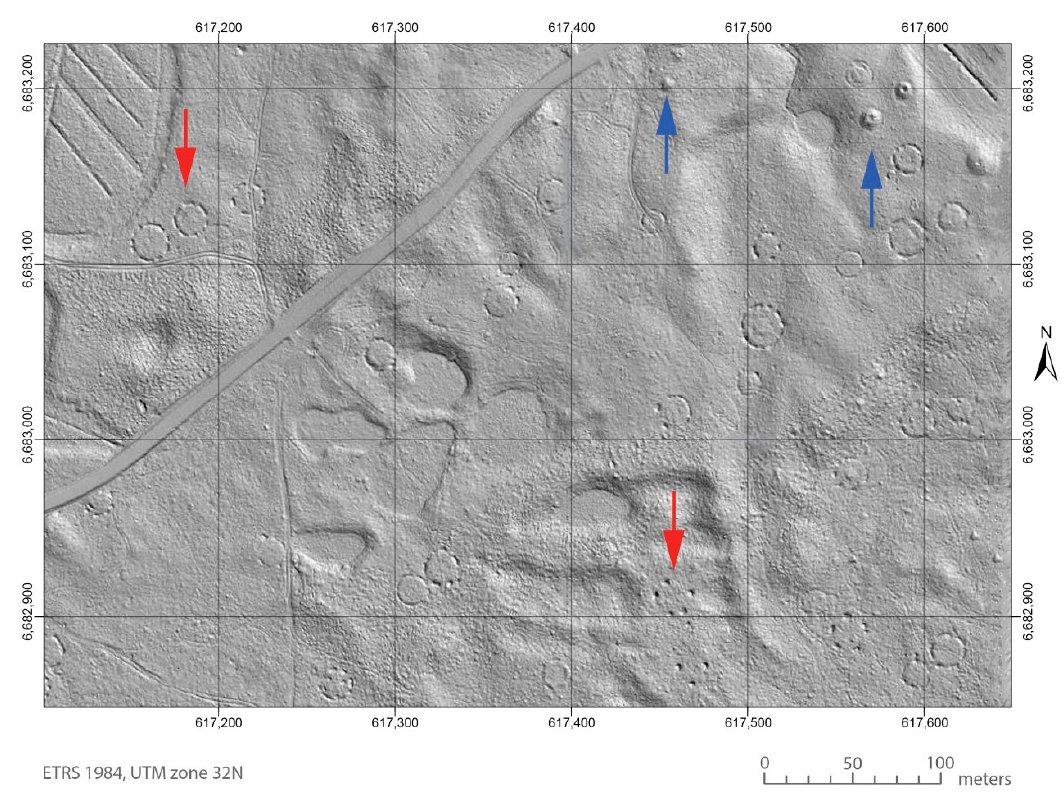
Figure 3. This example from the Eidsvoll municipality shows a section of a forest holding a large number of cultural features, in this case mainly charcoal kilns that appear as solid and dotted-lined circles spread across the area (examples are indicated with red arrows). A few burial mounds appear as convex features at the upper right-hand part (examples are indicated with blue arrows). The presence of modern roads and drainage ditches (herringbone pattern in the left-hand corner) is also apparent. The high density of charcoal kilns in this area is due to the nearby Eidsvoll ironworks, established in 1624 and operational more or less continuously until 1822 [46,47]. (Illustration: Ole Risbøl).